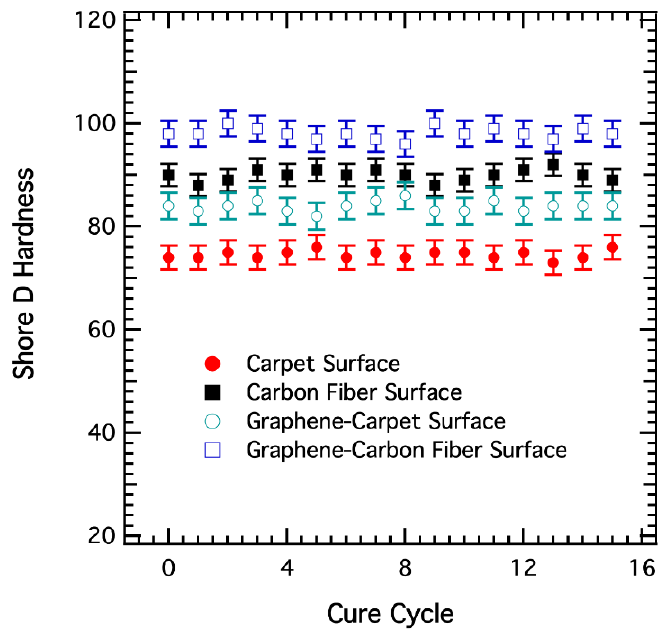
Figure 3. Shore D hardness as a function of curing cycles.